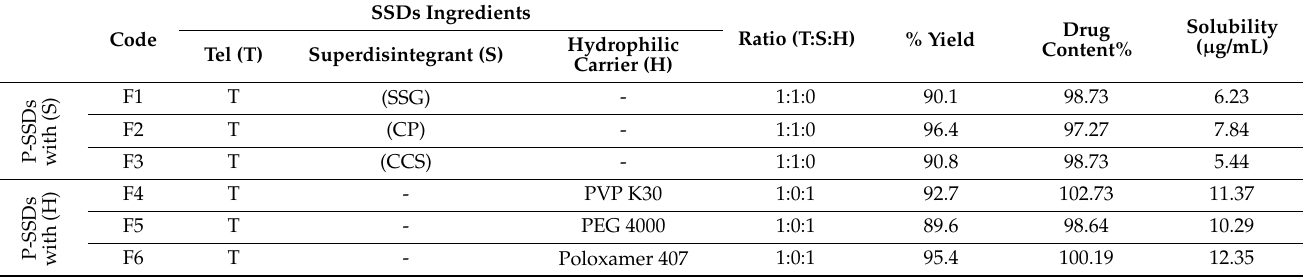
Table 1. Tel SSDs composition, percentage yield, drug content percentage and saturation aqueous